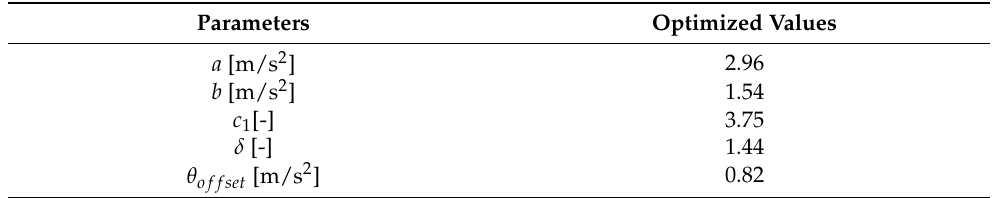
Table 2. Calibrated EDM parameters.